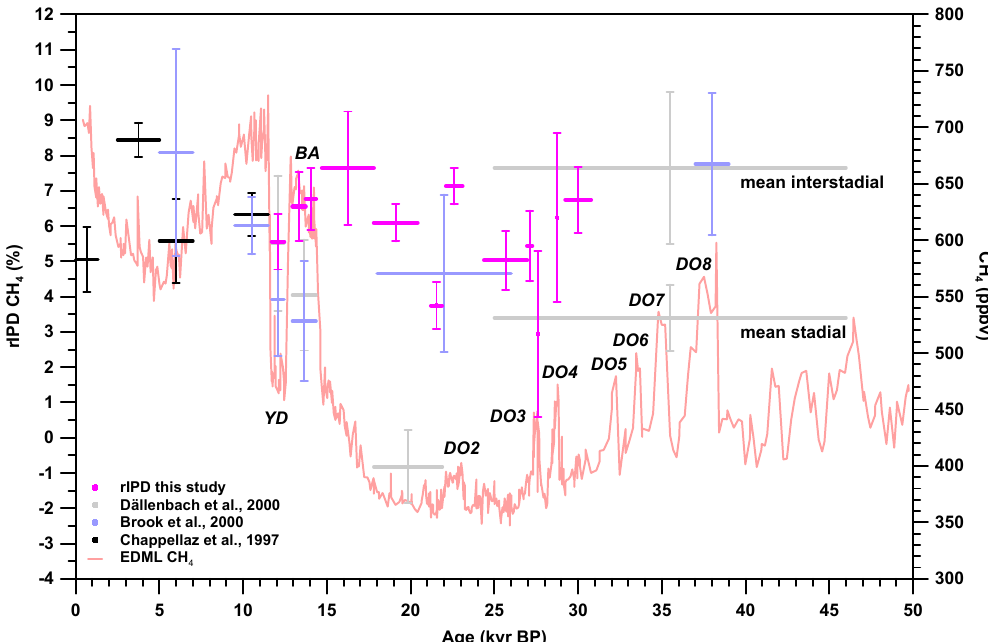
Fig. 3. Compilation of rIPD values for atmospheric CH 4 reconstructed from polar ice cores. Values from previous studies are given in black (Chappellaz et al., 1997): based on GRIP, D47 and Byrd; blue (Brook et al., 2000): based on GISP2 and Taylor Dome; and grey (D¨allenbach et al., 2000): based on GRIP, Byrd and Vostok. New values, corresponding to the time intervals of Fig. 1 and Table 1, are shown in pink. The CH 4 concentration from EDML is plotted in red. All data are synchronised to the unified EDML gas age scale derived by Lemieux-Dudon et al.